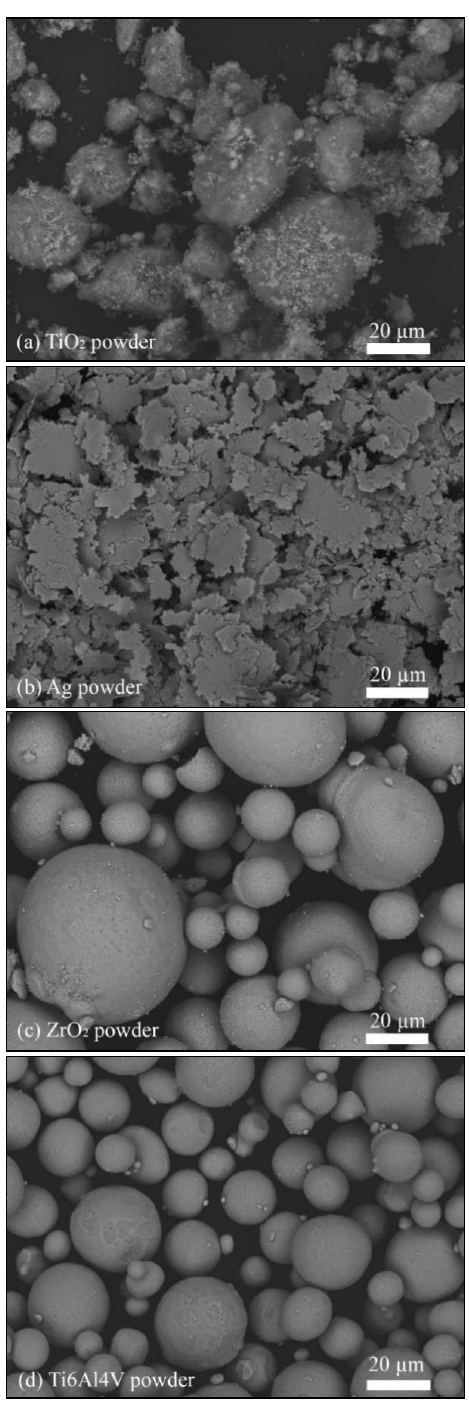
Figure 1. SEM micrographs of ( a ) TiO 2 anatase, ( b ) Ag, ( c ) ZrO 2 , and ( d ) Ti6Al4V powders.